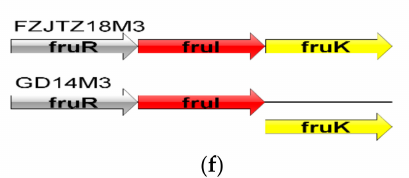
Figure 3. Genotype-phenotype analysis of carbohydrate utilization of 93 L. mucosae strains: ( a ) Utilization of 24 kinds of carbohydrates. ( b ) Predicted glycoside hydrolases and transferase \ prediction of gene cluster for utilization of lactose ( c ), trehalose ( d ), L-arabinose ( e ), and D-fructose ( f ). 3.5. Prediction of the EPS Operon in L. mucosae EPS production was one of the characteristics of L. mucosae .